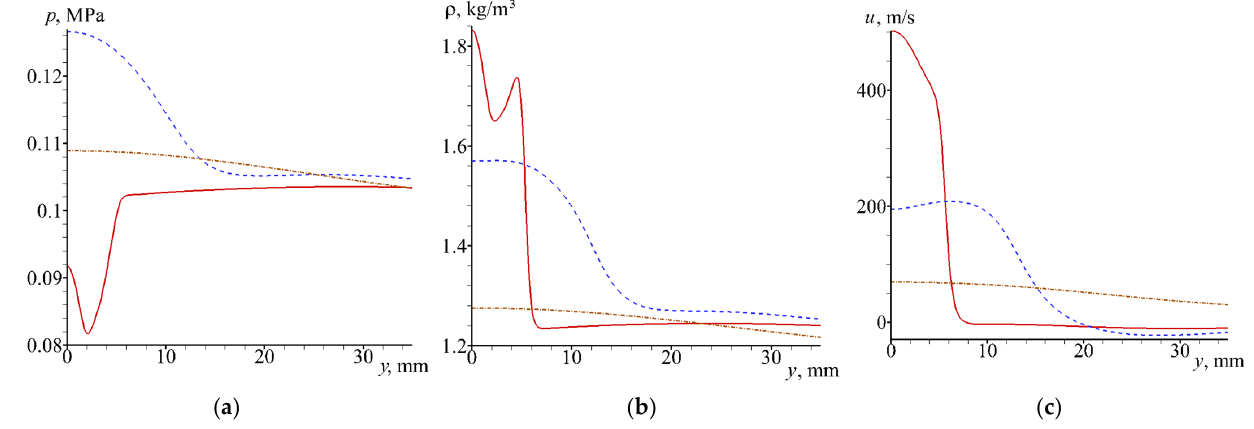
Figure 16. The distribution of gas parameters across the jet in the gas flow between wide disks: ( a )—pressure p ( y ) ; ( b )—density ρ ( y ) ; ( c )—longitudinal gas velocity u ( y ) . The solid red lines cor- respond to the section x = 25 mm; the dashed blue lines, to the section x = 40 mm; and the dash-and-dot brown lines, to the section x = 70 mm.